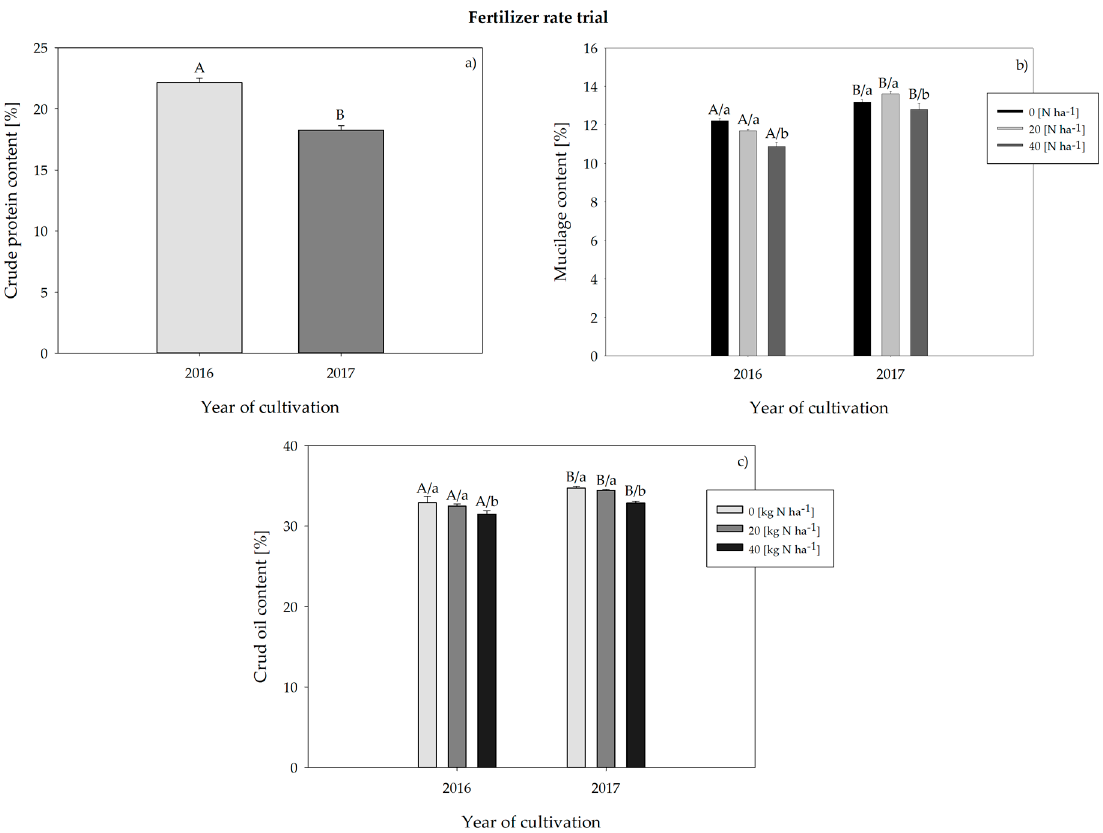
Figure 4. Mean estimates of crude protein ( a ), mucilage ( b ) and crude oil ( c ) content of the genotype G8 cultivated in 2016 and 2017 at Ihinger Hof at different fertilizer rates. Means at a constant level of fertilization rate that share a common capital letter do not differ significantly between years at α = 0.05. Means within a year that share a common lowercase letter do not differ significantly between fertilization levels at α = 0.05. (estimates, standard errors, and Tukey HSD test are based on model (2), for F ‐ test results compare Table S1).